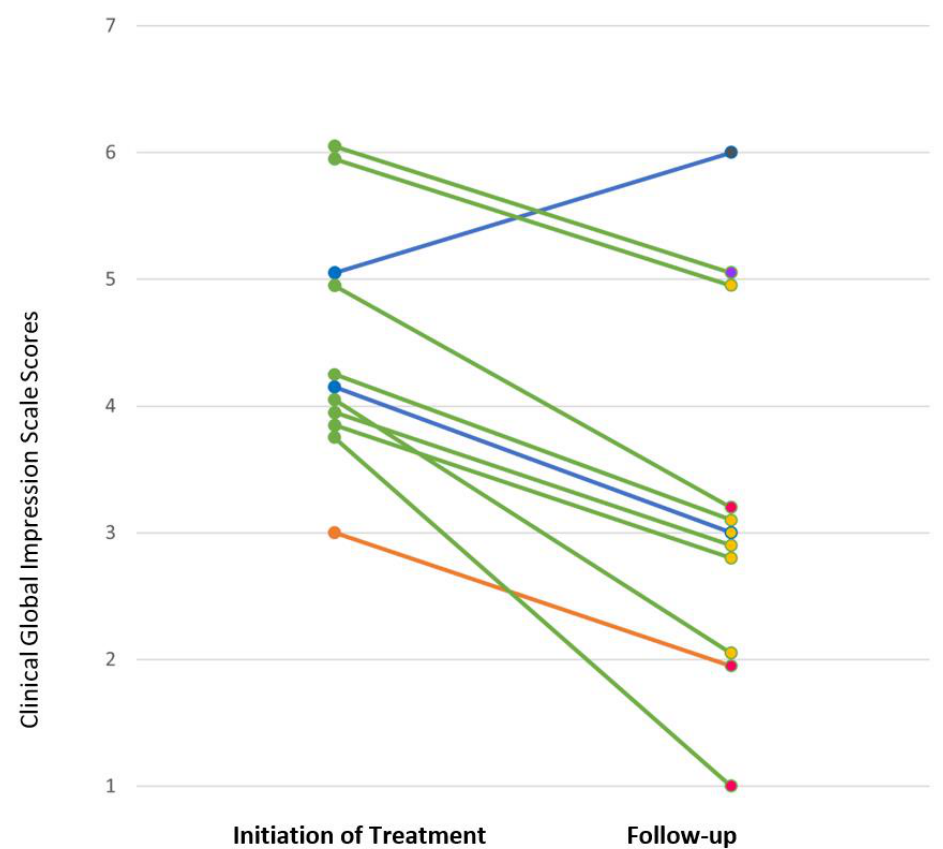
Figure 2. Clinical Global Impression Severity Scale (CGI-S) scores at the initiation of SSRI treatment and at first follow-up visit following 12 weeks of treatment. Each line represents the change in CGI-S score for one patient. Line color corresponds to SSRI: green = fluoxetine, blue = sertraline, orange = escitralopram. Color of marker at follow-up corresponds to CGI-Improvement scale (CGI-I) score: pink = very much improved (CGI-I = 1), yellow = much improved (CGI-I = 2), purple = minimally improved (CGI-I = 3), gray=minimally worse (CGI-I = 5).